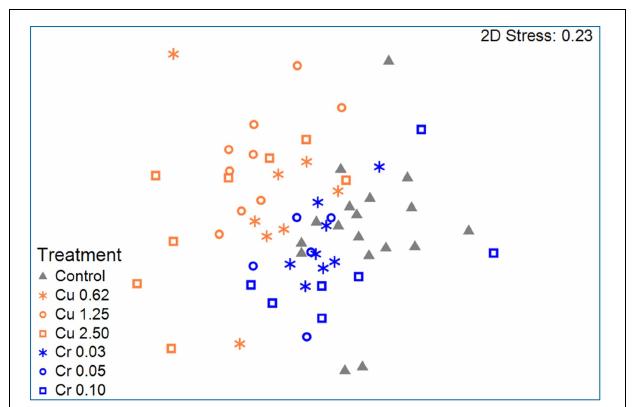
FIGURE 2 | An NMDS (non-metric multidimensional scaling) plot of the bacterial community composition of larvae that were exposed to copper or hexavalent chromium vs. the control (stress value = 0.23). Significant differences were found between the bacterial communities of the control, the hexavalent chromium, and the copper treated larvae (ANOSIM: R = 0.476, p = 0.001). Adopted with permission from Laviad-Shitrit et al. (2021).